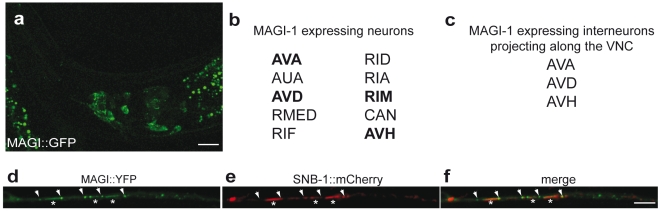
Expression pattern and sub-cellular localization of MAGI-1::GFP.a, expression of the rescuing magi-1::gfp construct in the head of an adult worm visualized by fluorescence confocal microscopy. b and c, list of the neurons expressing MAGI-1. MAGI-1 and GLR-1 double positive cells are indicated in bold. Neurons that project their processes along the ventral nerve chord are listed in c. d–f, co-localization of MAGI-1::YFP with the presynaptic marker, synaptobrevin (SNB-1) driven by endogenous promoters. Asterisks label the synaptic area, arrows point to the punctae flanking the synaptic cleft. Scale bars represent 10 µm on panel a, and 1 µm on panel f.